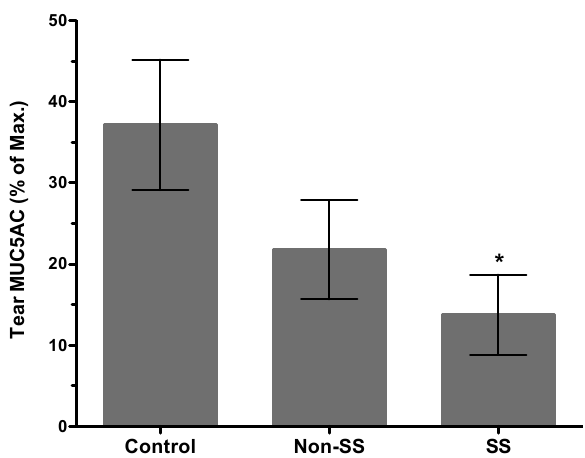
Figure 3. Distinctly reduced tear MUC5AC levels in patients with Sjögren’s associated dry eye. Comparison of tear MUC5AC levels in patients with non-Sjögren’s (non-SS) and Sjögren’s (SS) associated dry eye with healthy control subjects. ( n = 20 per group, * p < 0.05 compared to control group).